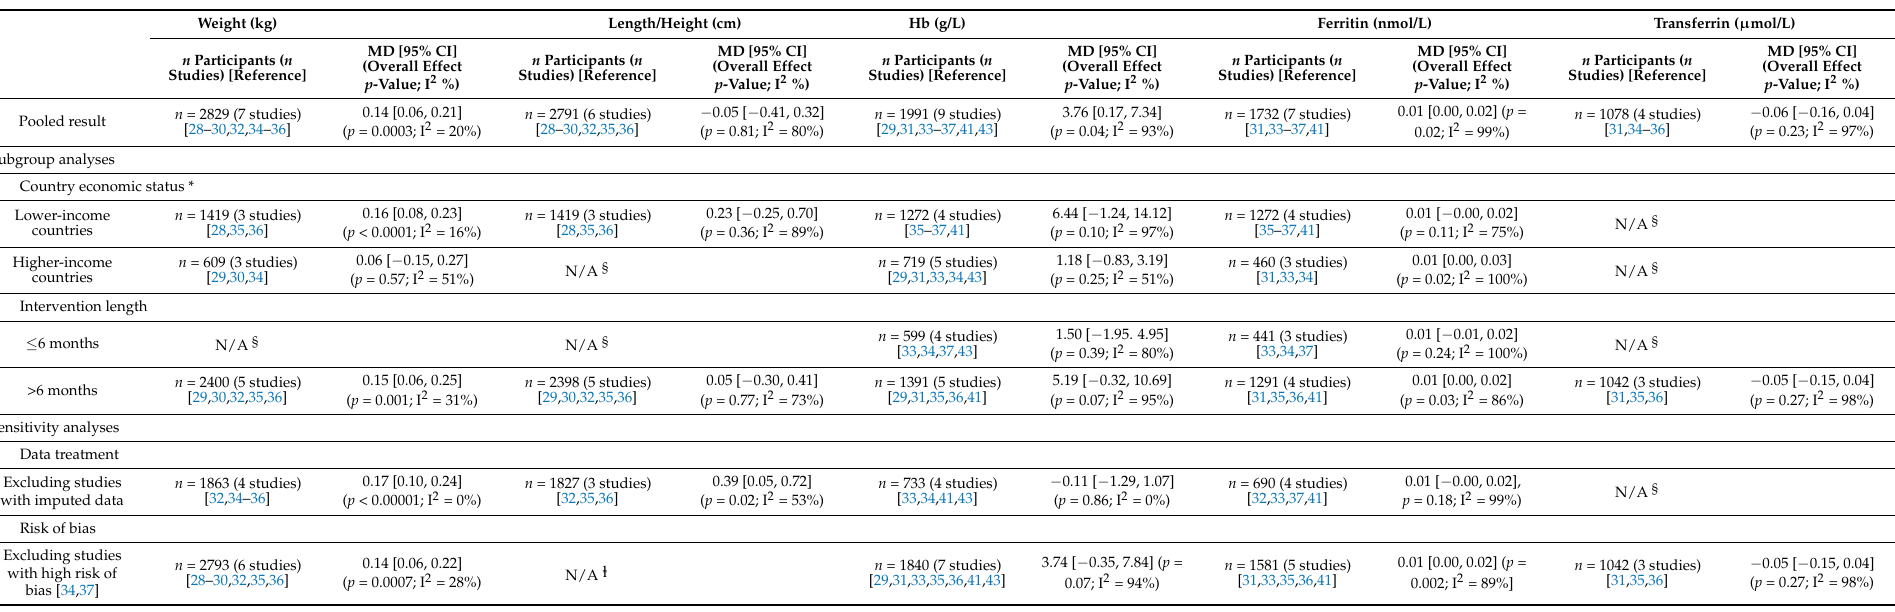
Table 4. Meta-analysis results of the overall effect (pooled data), subgroup, and sensitivity analyses of selected outcomes.